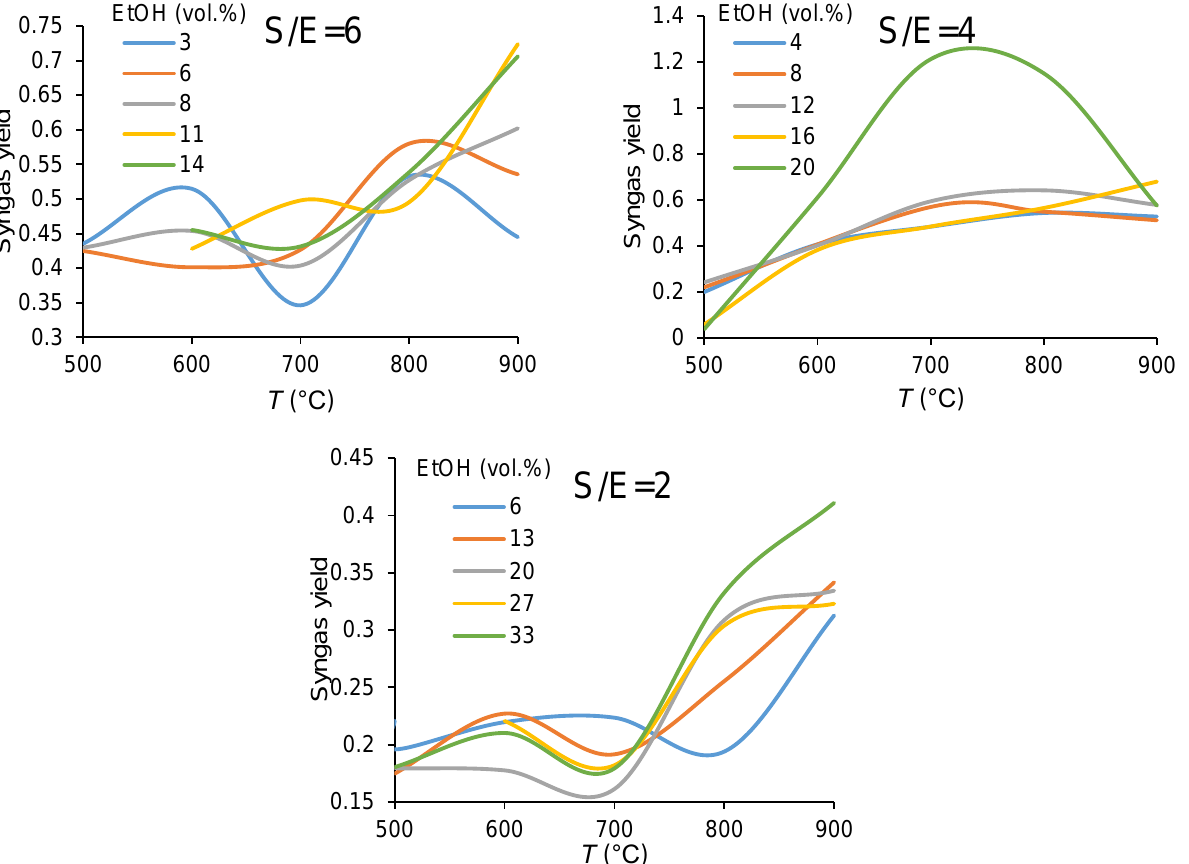
Figure 7. Temperature dependencies of syngas yield in ethanol steam reforming in CMR at different ethanol concentrations (in vol.%) and the steam-to-ethanol molar ratios in the feed.